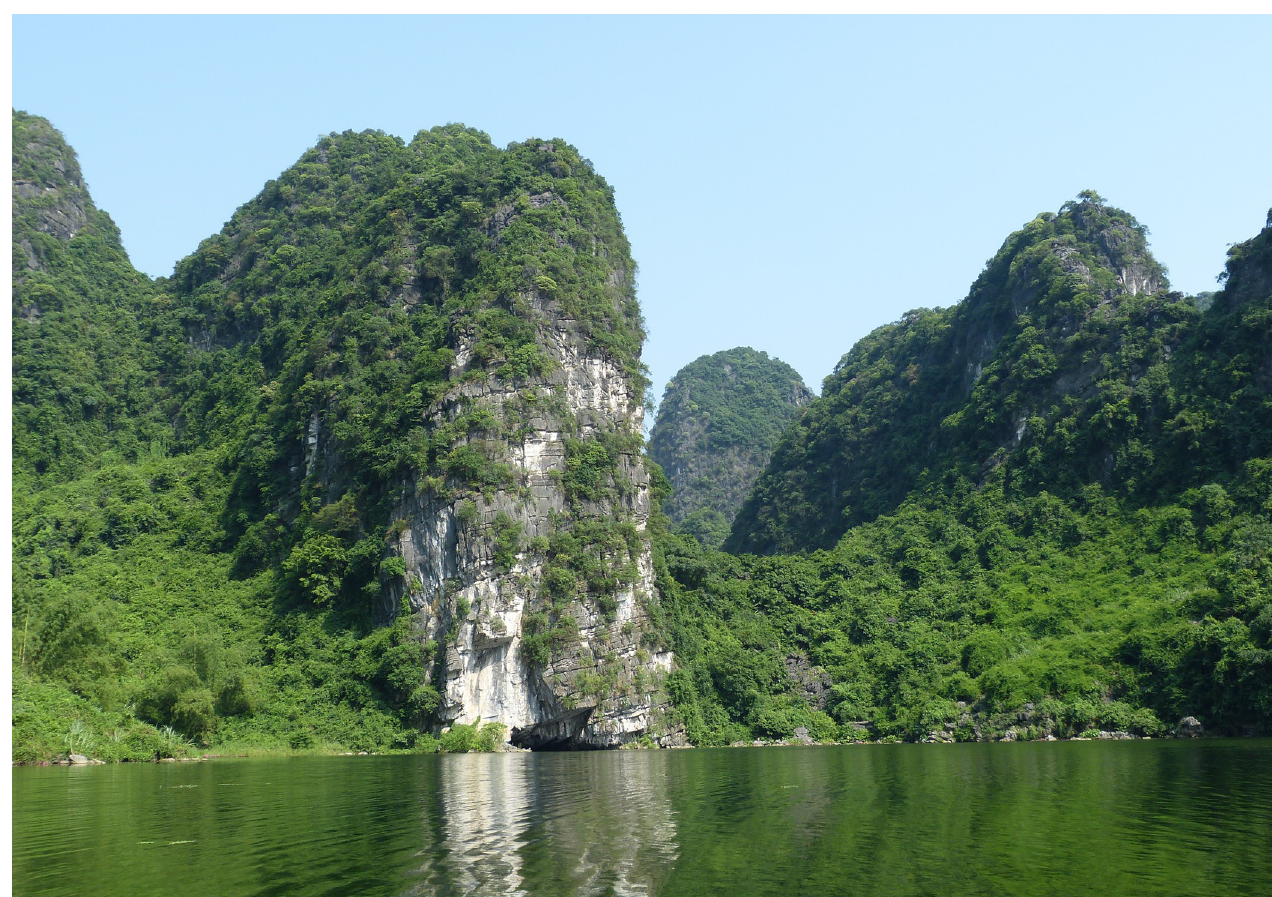
Fig 8. Vegetation cover on the Tr à ng An limestone massif. Palaeoenvironmental evidence from Tr à ng An indicates that broad habitat conditions found on the massif today extend back to at least the Late Pleistocene (Photo: Ryan